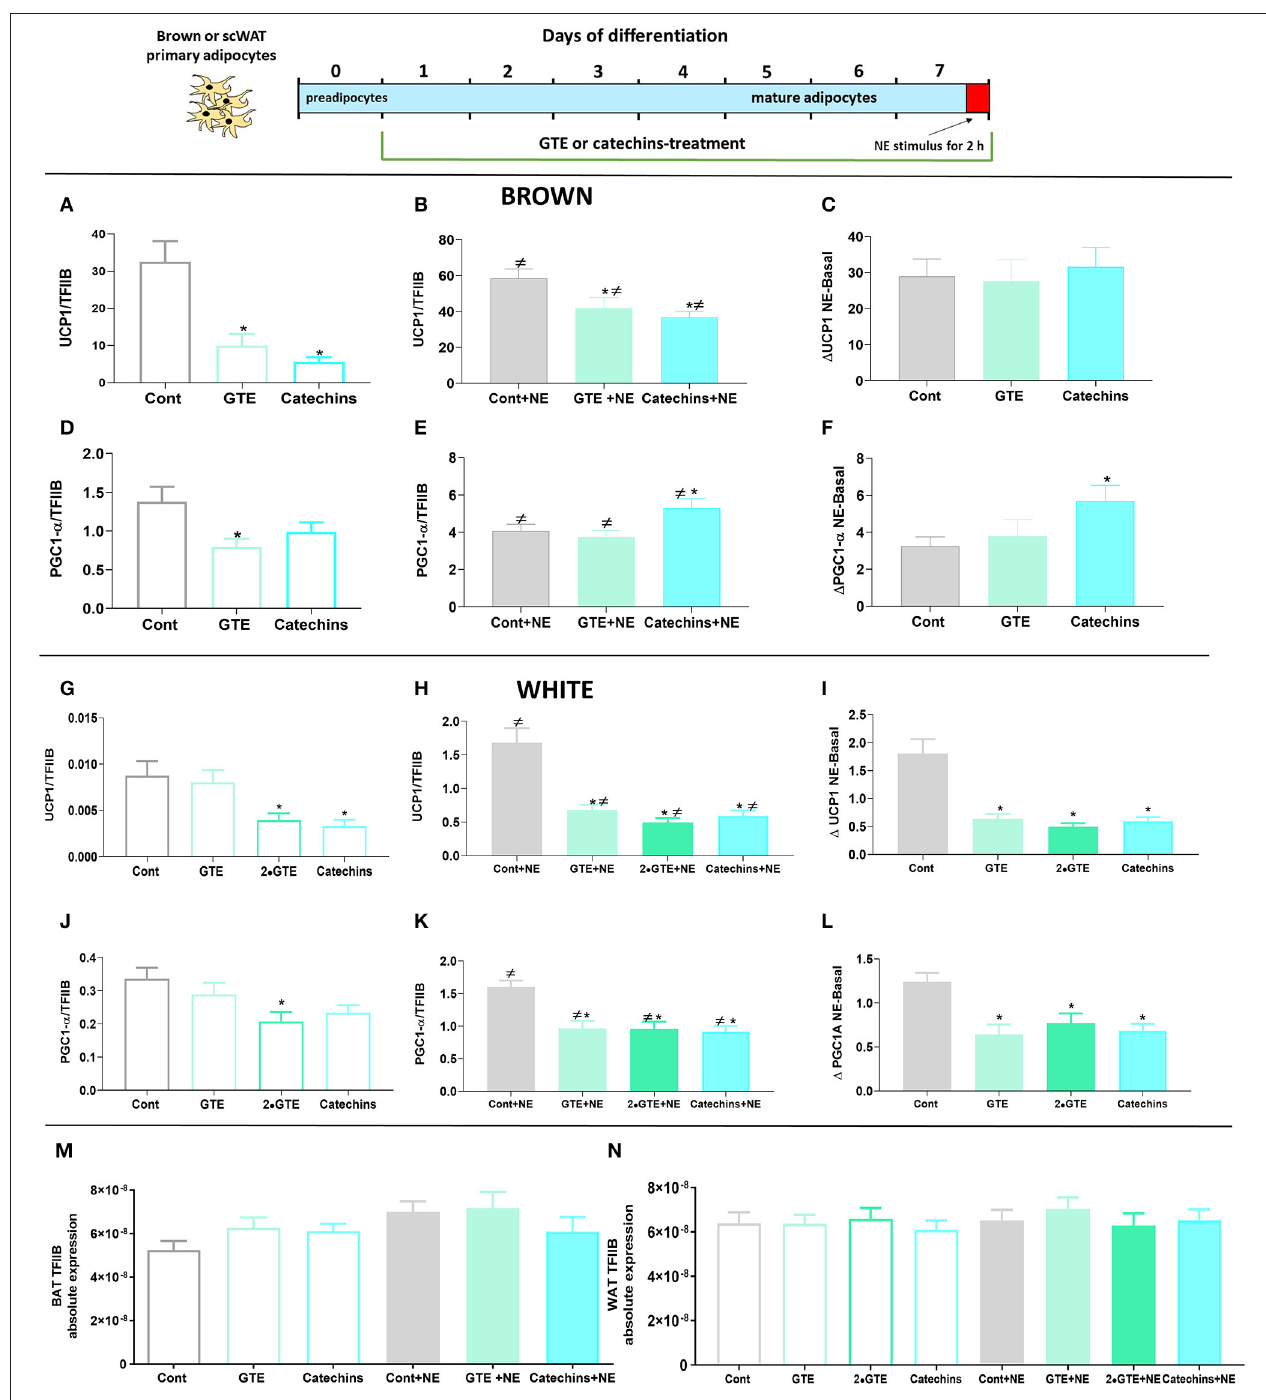
FIGURE 1 | Effect of chronic treatment with green tea compounds on expression of thermogenic genes in primary adipocytes. Primary brown and white adipocytes were treated for 7 days with green tea extract (GTE, 1.9 and 3.8 µ g/ml, 2 • GTE) or catechins (4 µ M). Two hours before harvesting, 1 µ M norepinephrine (NE) was added to the cell cultures. (A–C) Brown adipocyte Ucp1 mRNA levels: basal (A) , norepinephrine (NE)-stimulated (B) , and the increase due to norepinephrine ( B minus A ) (C) . (D–F) Brown adipocyte Pgc1 α mRNA levels, as in ABC. (G–L) Corresponding data for white adipocytes. Ucp1 and Pgc1 α mRNA levels were expressed relative to the TFIIB levels in each sample ( M : TFIIB mRNA levels in brown and N in white adipocytes). The results are means ± SEM of five independent experiments, each performed in duplicate. Statistical differences were determined by one-way ANOVA and Tukey’s post-test. * p < 0.05 compared with the respective control group. 6= p < 0.05 compared with the respective basal group. For gene abbreviations, as shown in Table 1 .